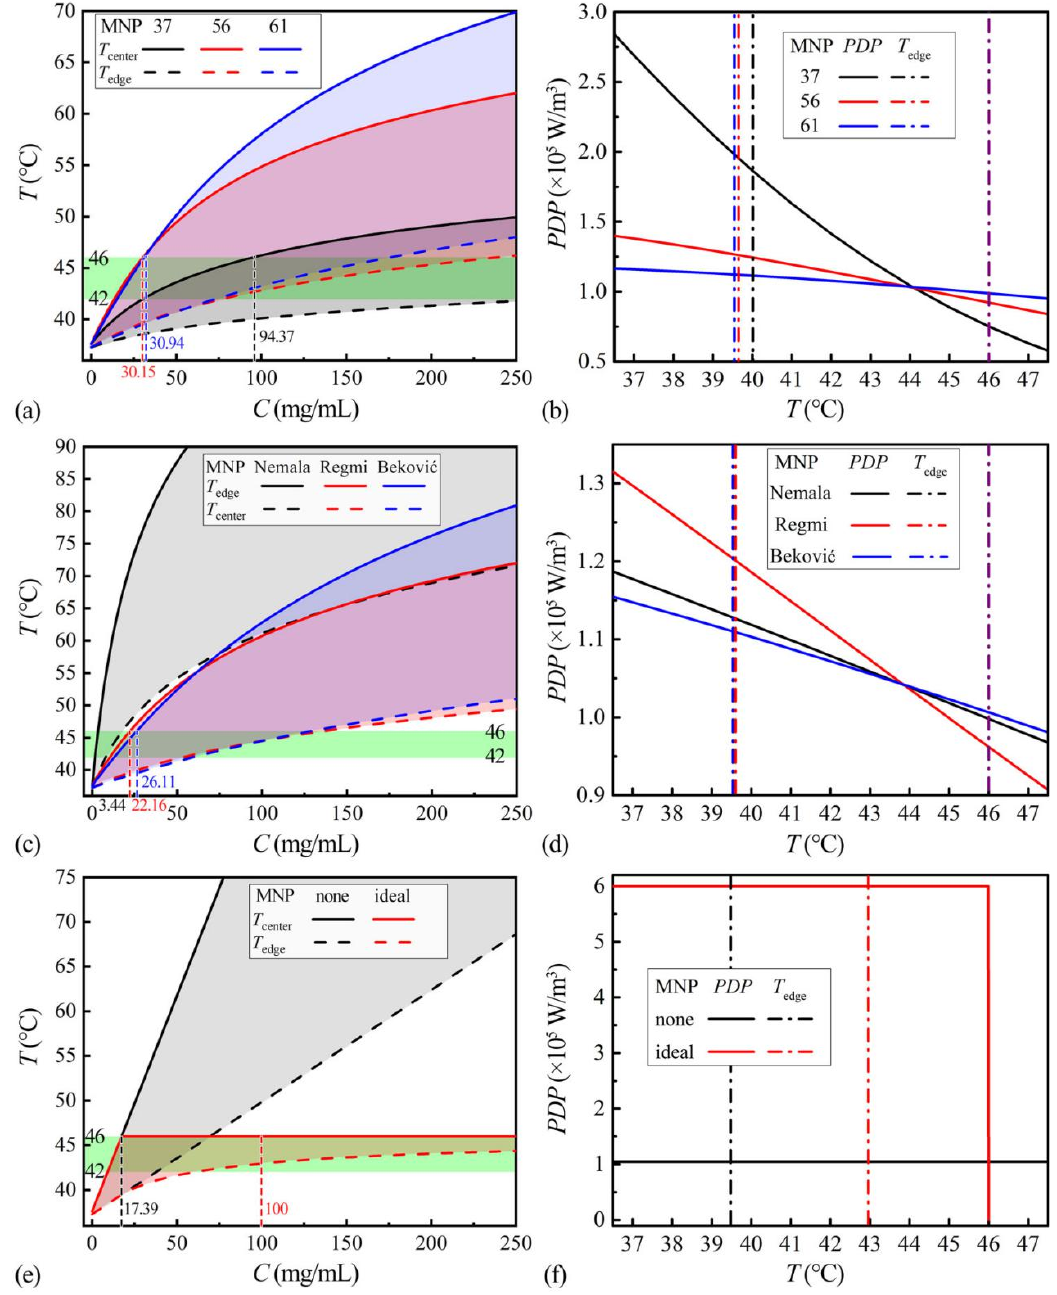
Figure 5. The temperature range ( T center - T edge ) at different MNP concentrations of MNP 37 , MNP 56 and MNP 61 ( a ); of MNP Nemala , MNP Regmi and MNP Bekovi ć ( c ); of MNP none and MNP ideal ( e ). The PDP - T curves at proper concentrations for T center 46 °C of MNP 37 , MNP 56 and MNP 61 ( b ); of MNP Nemala , MNP Regmi and MNP Bekovi ć ( d ); of MNP none and MNP ideal ( f ). After confirming their abilities to heat the tumor to 46 °C, whether the corresponding AMF conditions and concentrations are safe still needs to be investigated. High AMF in- tensity or frequency may cause pain [1]. Normally, the safe criteria for AMF are “intensity ( H ) × frequency ( f ) < 5 × 10 9 A/(m·s)” [28]. High MNP concentrations may lead to cytotox- icity [14]. The maximum ever applied MNP concentration, recorded in clinical trials, is 280 mg/mL [29]. With regards to the ZnCoCrFeO MNPs, the AMF conditions of 100 kHz and 400 Oe (32 kA/m) in calorimetry experiments and the chosen MNP concentrations of 30–95 mg/mL in Figure 5a may be acceptable. For the MNPs in Figure 5c, the chosen AMF